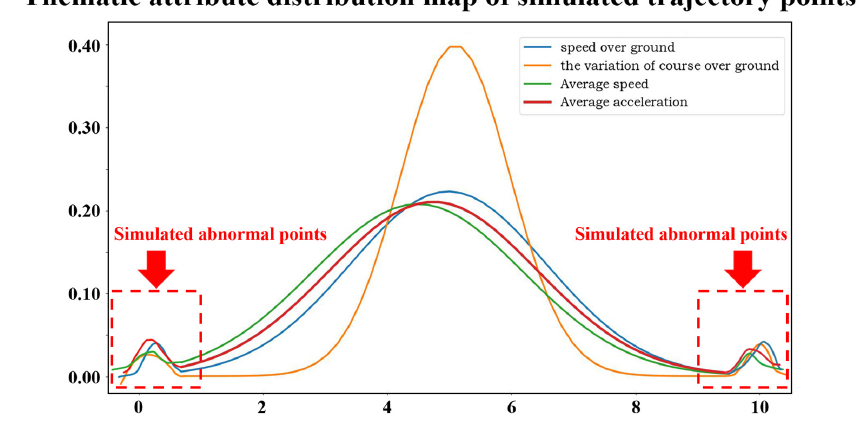
Figure 8. Simulation data for abnormal behavior of ship thematic attributes.